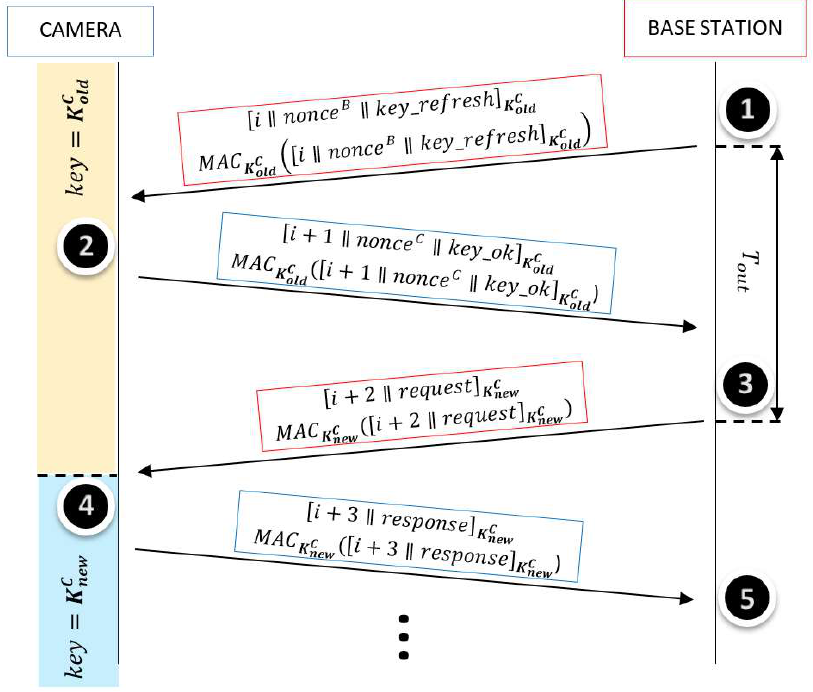
Figure 2. Proposed lightweight protocol.